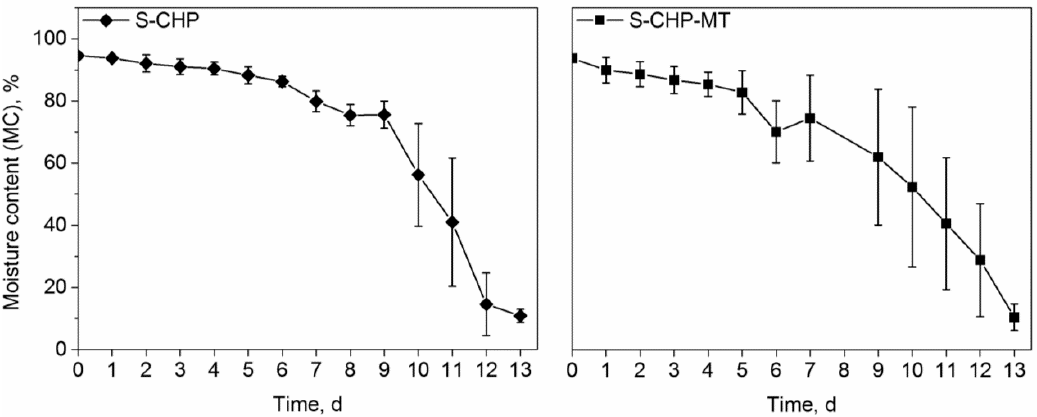
Figure 5. Course of moisture content MC during drying of biogas digestate; (left) variant S-CHP with solar energy and waste-heat of a combined heat and power unit; (right) variant S-CHP-MT with solar energy, waste-heat of a combined heat and power unit and exhaust air of a micro turbine. Mean values of 20 spatial grid measurement, error bars represent the standard deviation.